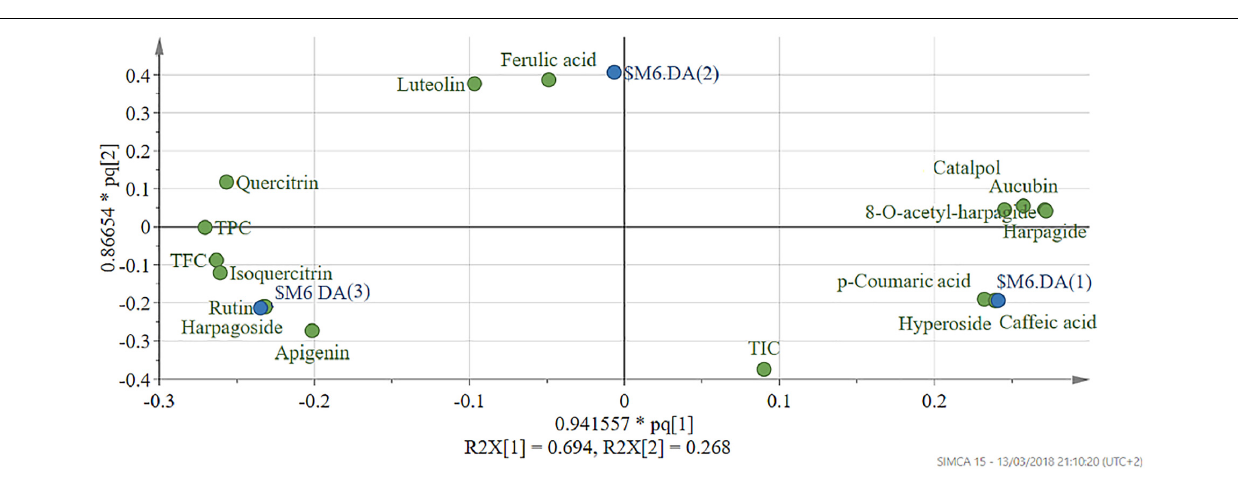
FIGURE 10 | Loading scatter plot of OPLS-DA model – pq(1) vs. pq(2). Physicochemical descriptors in relation to the artificial dummy variables that reflect class membership: $M6.DA(1)-EEAG; $M6.DA(2)-EEAC; $M6.DA(3)-EEAL. p- X loading weight; q- Y loading weight. EEAG, A. genevensis ethanolic extract; EEAC, A. chamaepitys ethanolic extract; EEAL, A. laxmannii ethanolic